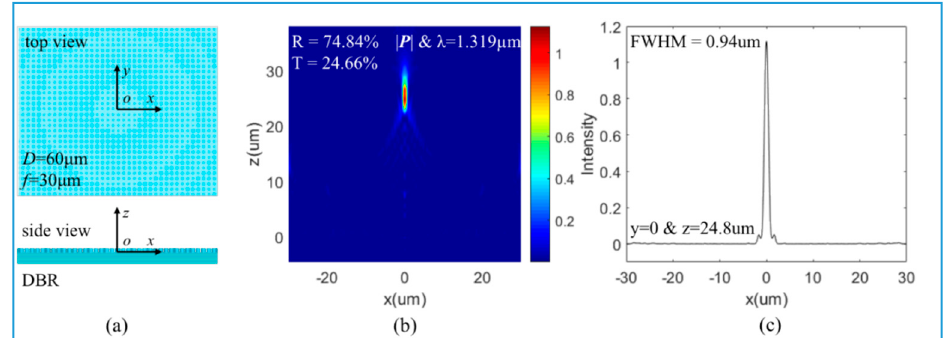
Figure 4. Focal features of meta-reflectors with DBR: ( a ) schematic of a meta-reflector with DBR as bottom mirror, size D = 60 µm and focal distance f = 30 µm; ( b ) Focal profile of the reflected light on the x - z plane with y = 0; ( c ) FWHM of the focus spot at z = 24.8 µm.